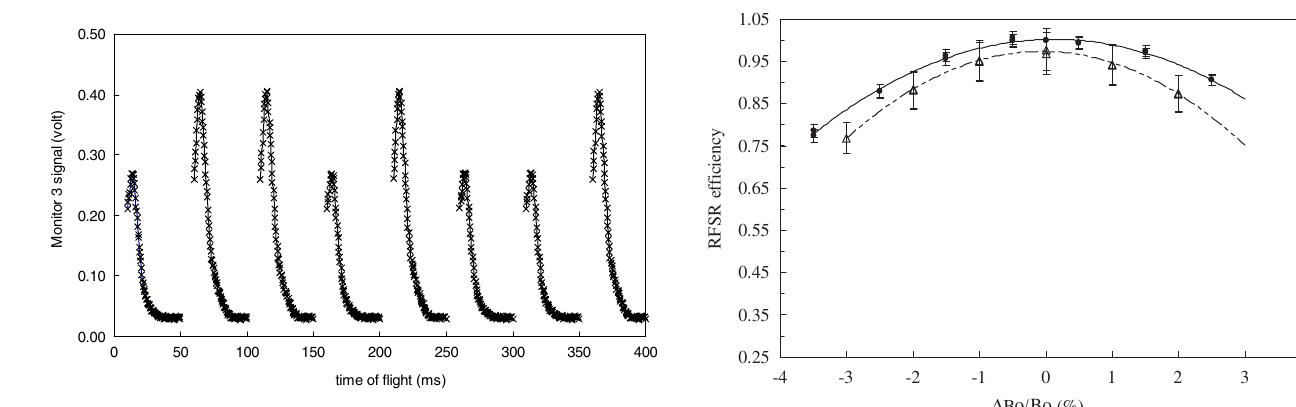
FIG. 9. Measured efficiencies of the RFSR are shown in a function of a relative change in the static magnetic field. Triangles are measured with the RFSR-flip method and solid points with the AFP 3 He flip method. Lines are results of quadratic fits to the data set.